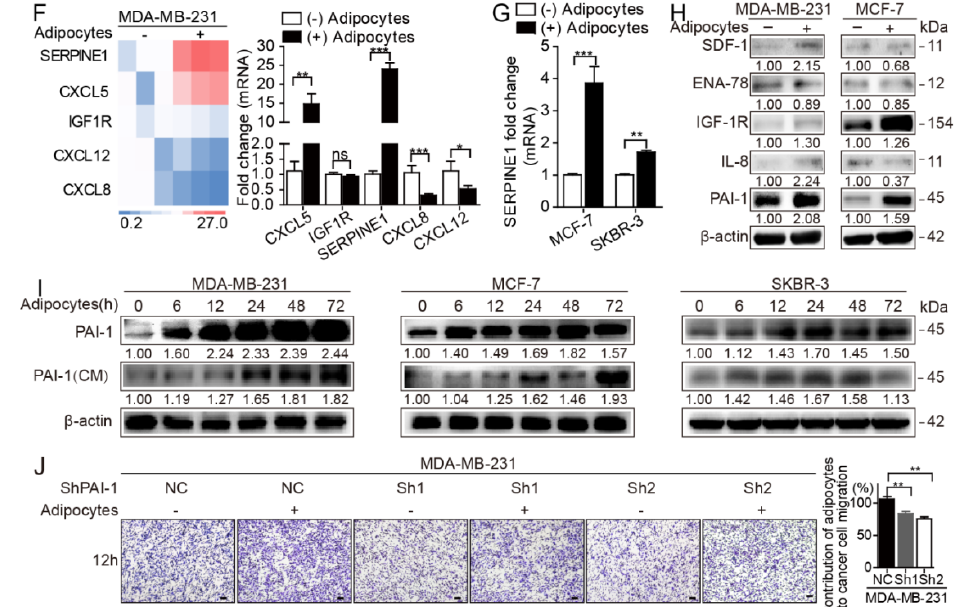
Figure 2. Adipocytes facilitate the migration of breast cancer cells by inducing PAI-1 expression. ( A , B ) Analysis of cytokine protein arrays. Among the 62 detected cytokines in the CM of MDA-MB-231 (MDA-231) cells alone or with adipocyte coculture for 72 h, 18 cytokines were initially identified as having a fold change ≥ 1.50 or ≤ 0.66 in CM of cocultured cancer cells compared with control groups. Then, the metastatic scores of the above 18 cytokines in cancer were evaluated by the CHAT database (Metric: NPMI), and the top five cytokines were further chosen. ( C ) The expression of the candidate factors in breast cancer (BC) tissues. ( D ) The expression analysis of the candidate factors in breast cancer cell lines. ( E ) The expression of the candidate factors in TNBC and non-TNBC cell lines. ( F ) qRT-PCR assay. MDA-MB-231 cells were cultured ± adipocytes for 72 h, followed by the extraction of RNA and measurement of the expression of the indicated cytokines. Bars represent the means ± SEMs from three independent experiments. ( G ) PAI-1 alteration was explored in MCF-7 and SKBR-3 cells under identical conditions. Bars represent the means ± SEMs from three independent experiments. ( H ) Western blot. The indicated proteins were detected in cancer cells with or without adipocyte coculture for 72 h ( n = 3 independent experiments). ( I ) Western blot. Di ff erent cancer cell lines were cocultured with adipocytes for 0 h to 72 h, and the levels of PAI-1 in cancer cells and CM from the transwell inserts were detected by immunoblotting ( n = 3 independent experiments). ( J ) MDA-MB-231 cells with stable knockdown of PAI-1 were cultured ± adipocytes for 72 h, and transwell migration assays were employed to estimate the contribution of adipocyte-induced cancer cell migration via PAI-1. Bars represent the means ± SEMs from three independent experiments (* p < 0.05, ** p < 0.01, *** p < 0.001, ns: no significance). Scale bar = 100 µ